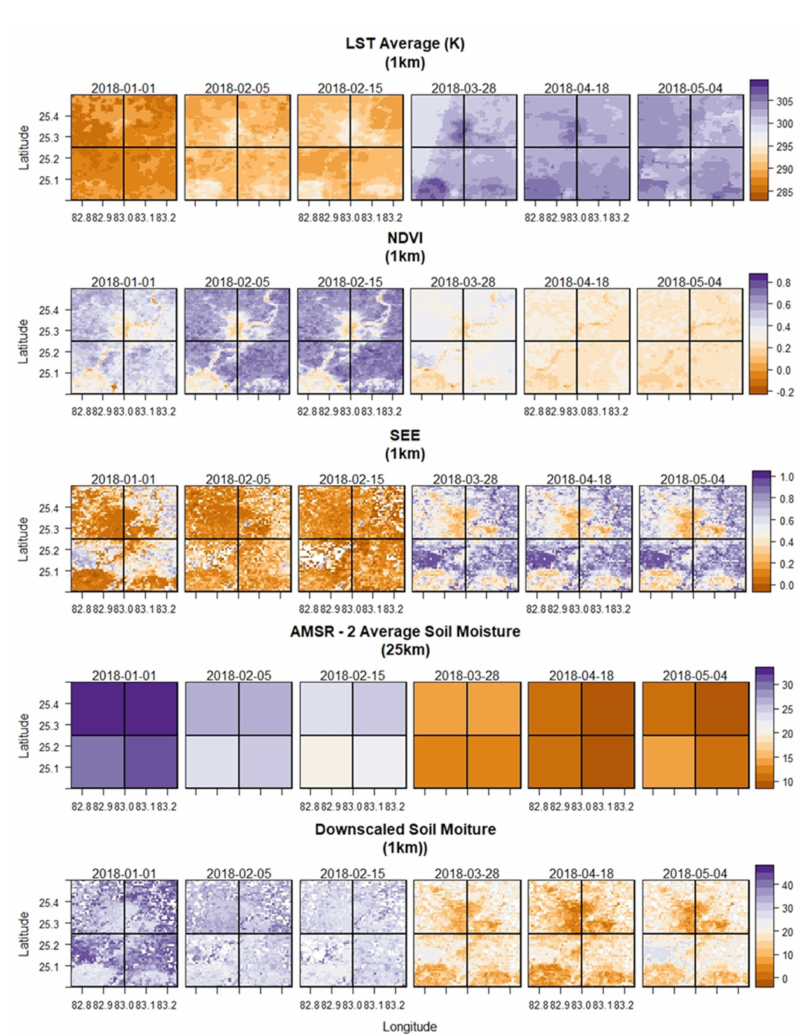
Figure 4. The seasonality captured in the values of LST, NDVI, SEE, and AMSR-2 soil moisture at 25 km resolution, and the corresponding 1 km resolution downscaled soil moisture of the selected days where the results have been compared with in-situ soil